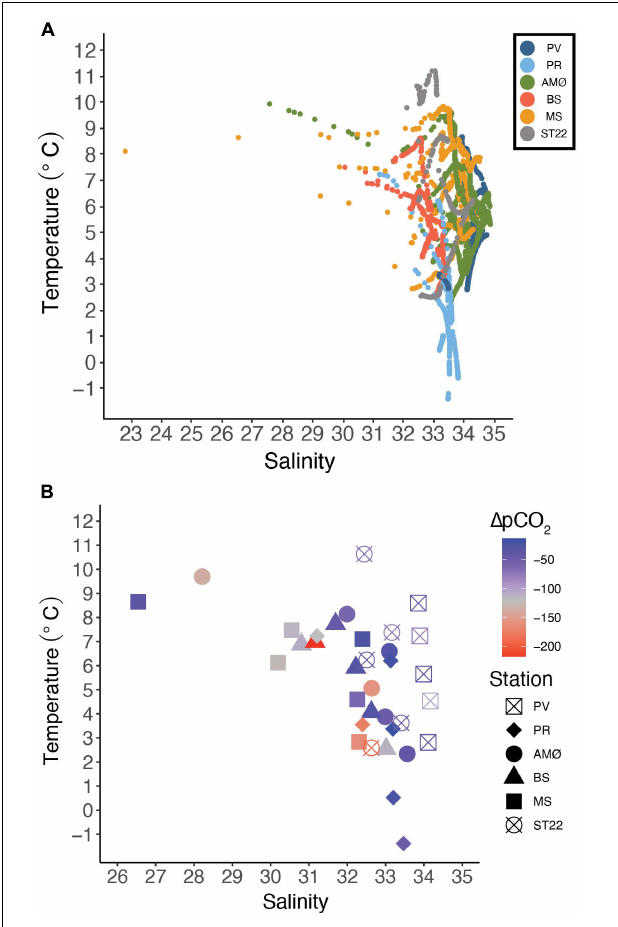
TABLE 1 | Mann-Whitney U test analysis of possible summer (April, May, and June) seasonality in variable of interest: CO 2 flux, (cid:49) pCO 2 , wind, chl a , and AU biomass.